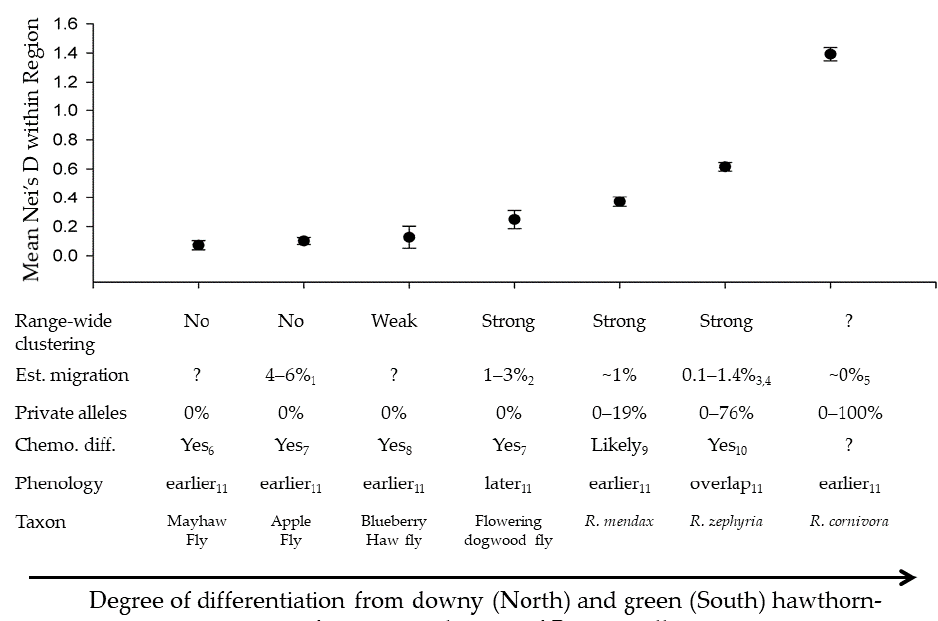
Figure 5. Summary of genetic and phenotypic differentiation in the R. pomonella species complex, including mean Nei’s D between each population of that taxon and each hawthorn-race R. pomonella within the respective region, the presence of range-wide clustering in population genetic distance networks, estimated migration from previous studies, the range of frequencies for alleles private to each taxon relative to R. pomonella , the presence of evidence for chemosensory behavioral differen- tiation from previous studies, and the relationship of host plant phenology to that of co-occurring R. pomonella . Subscripts denote the reference from which data was extracted: 1 = [50]; 2 = [22]; 3 = [87]; 4 = [88] ; 5 = [117]; 6 = [118]; 7 = [33]; 8= [119]; 9 = Linn CE, personal communication; 10 = [29]; 11 = [120].